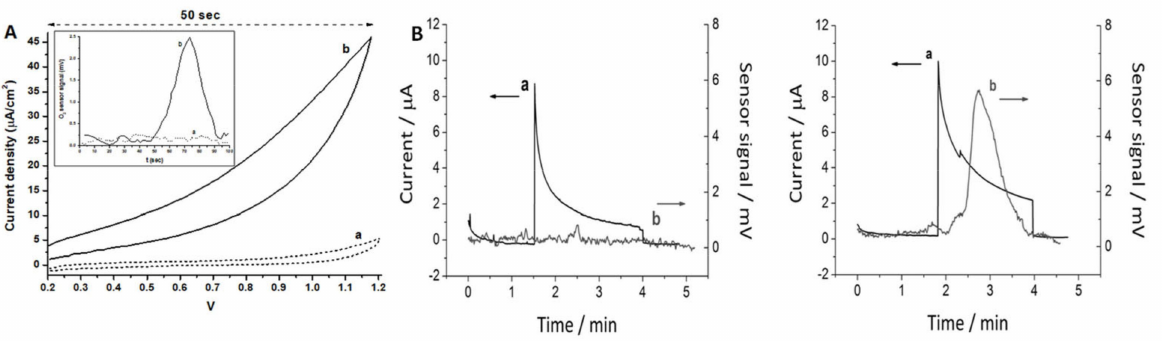
Figure 8. ( A ) Cyclic voltammograms of electrodes in dark (a) and under irradiation (b); the O 2 sensor signal is shown in the inset in both cases. ( B ) Chronoamperograms of electrodes without (left) and with laccase (right) irradiated during ca. 2.3 min, the O 2 sensor signal being also shown (Adapted from Ref.